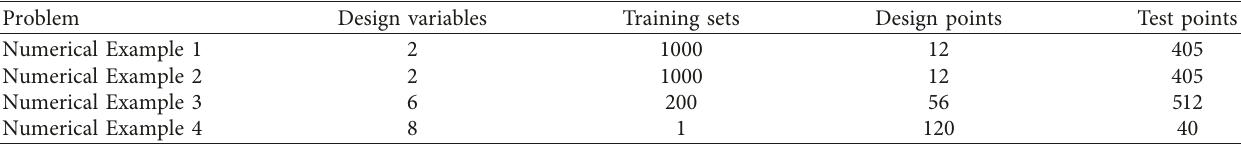
Figure 3: Stiffened plate under uniaxial compression in the longitudinal Table 1: Summary of training data and test data used in each problem.